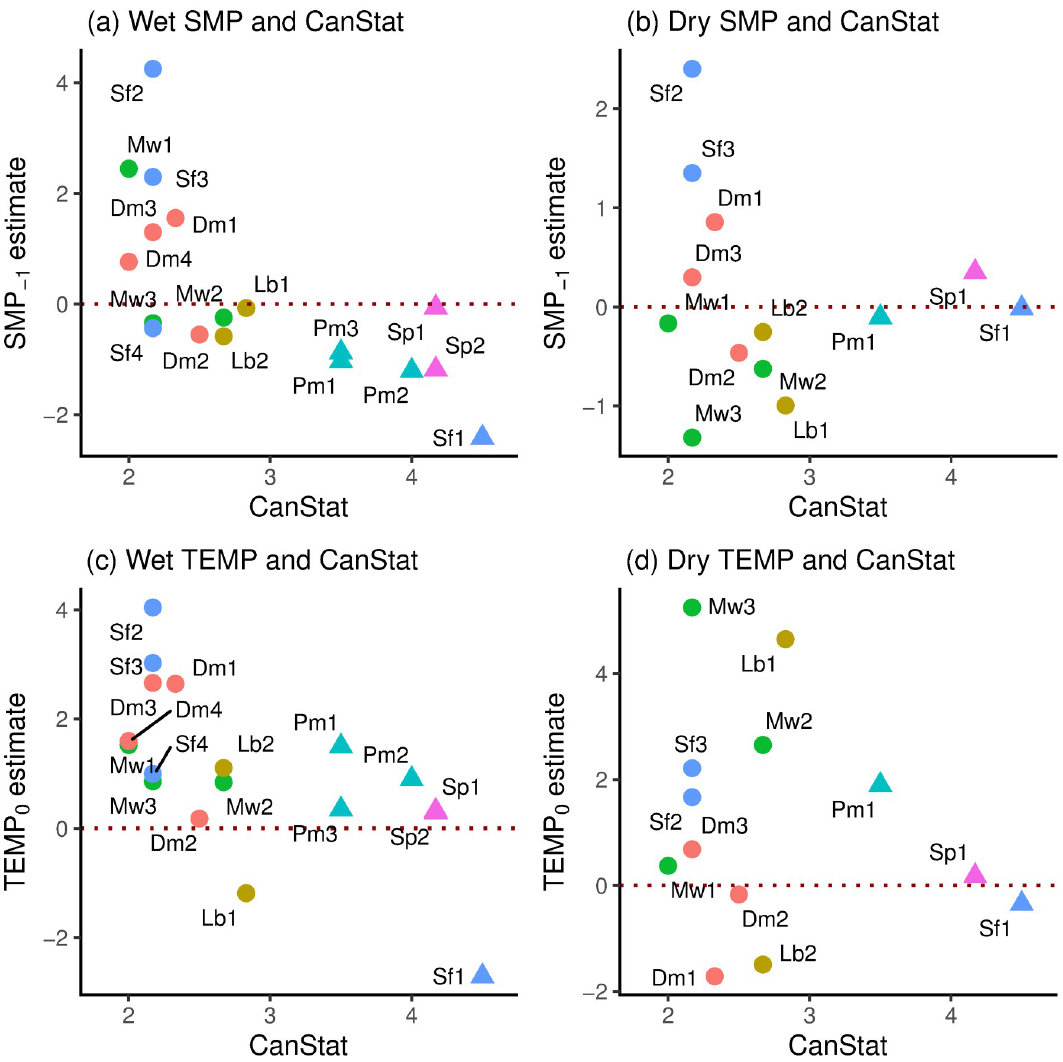
Fig 8. Standardized SMP − 1 and TEMP 0 coefficients in relation to canopy status ( CanStat ). Periods are wet (a, c; n = 18) and dry (b, d; n = 13). Symbols as in Fig